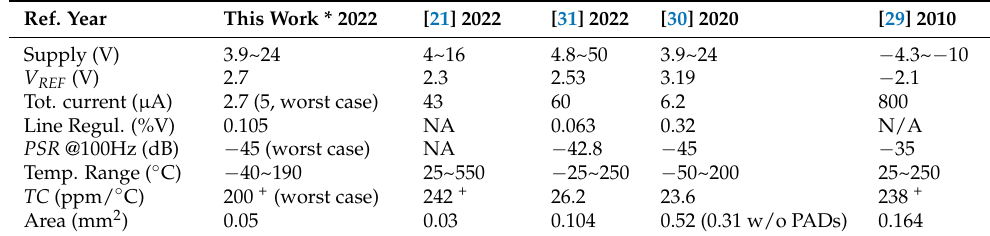
Table 3. Performance comparison of GaN voltage